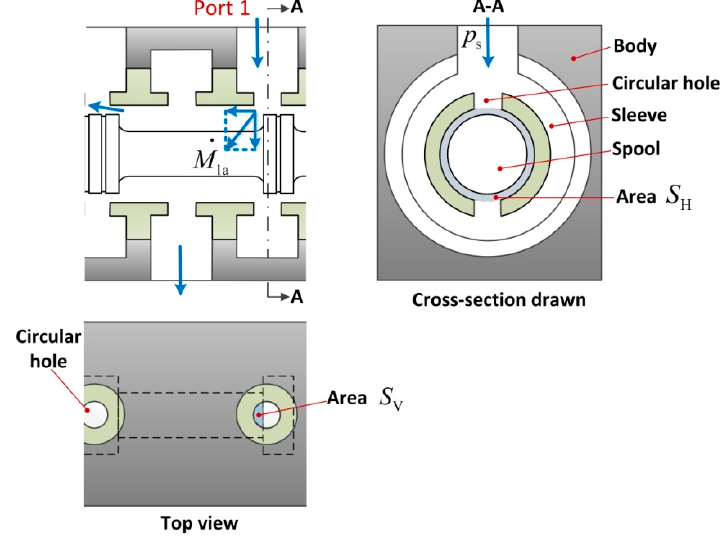
Figure 5. Flow splitting through orifice.